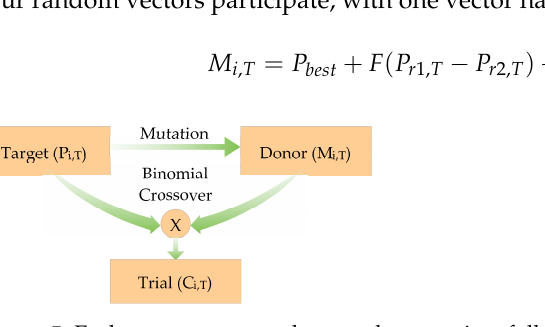
Figure 5. Each target vector undergoes the mutation, followed by the crossover